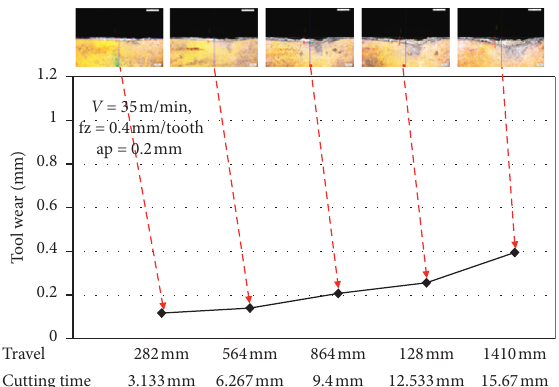
Figure 9: Tool wear under conditions of V � 35m/min, fz � 0.4mm/tooth, and ap � 0.2mm (conti.).